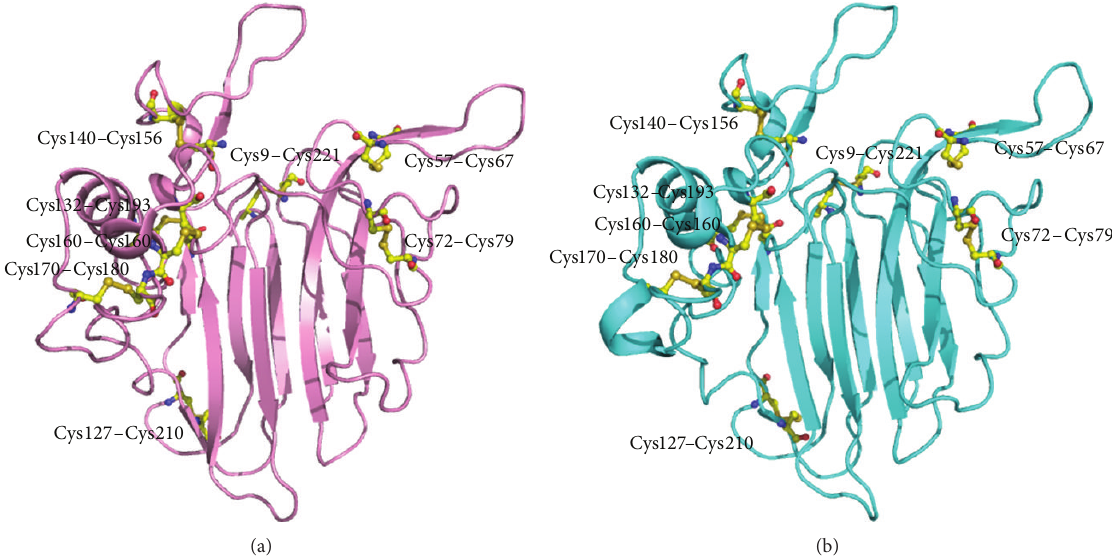
Figure 9: Three-dimensional structures of (a) Pru av 2 and (b) Mal d 2 showing the conserved cysteine residues.